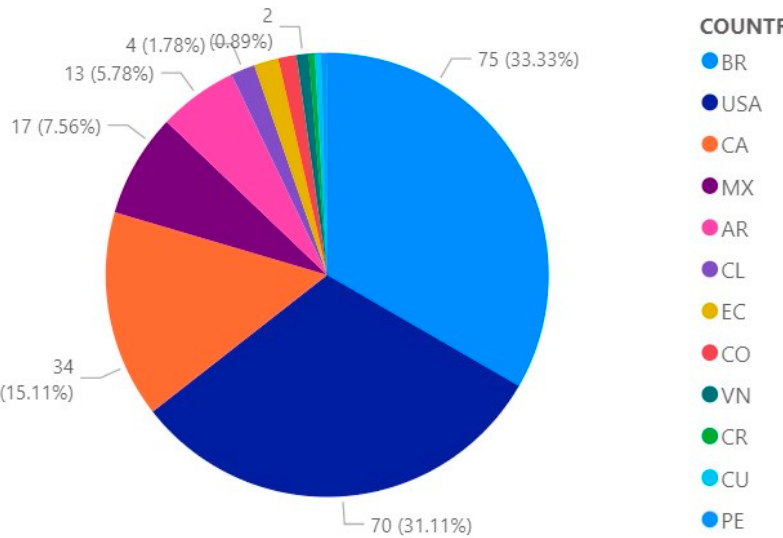
Figure 5. Contribution of scientific publications by country in Web of Science.